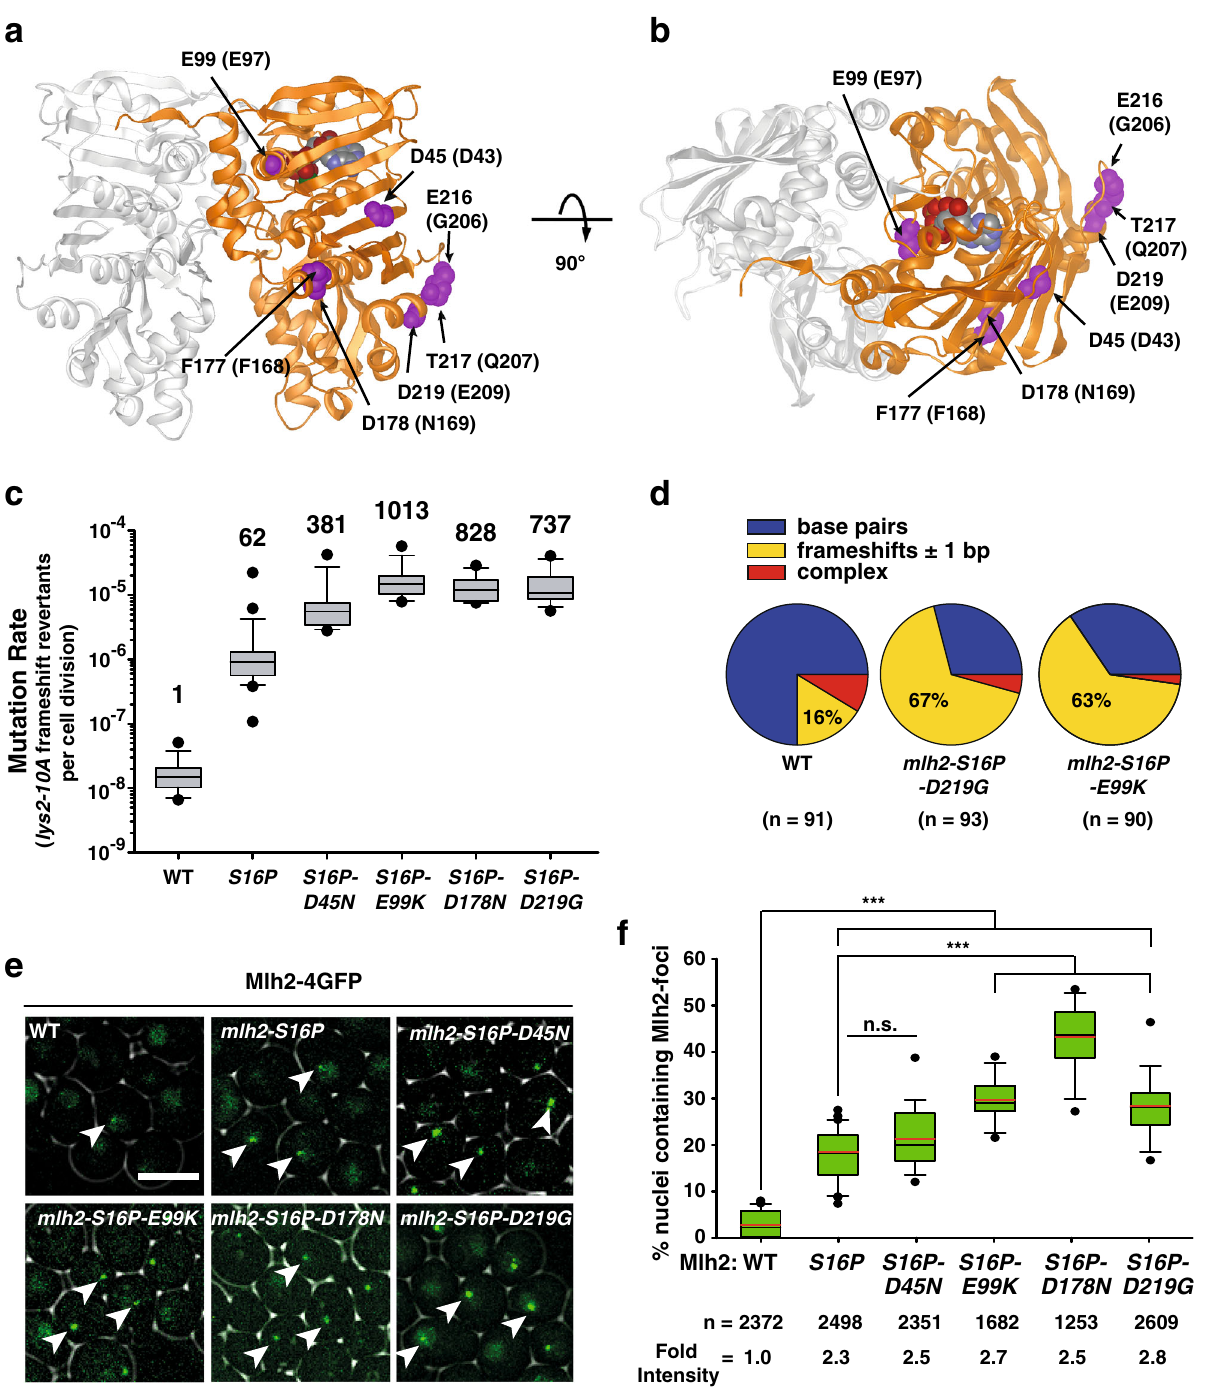
Fig. 2 Identi fi cation of mlh2-S16P mutational enhancer mutations. a Model of the Mlh1 – Mlh2 heterodimer structure (Mlh1 in gray, Mlh2 in orange) indicating residues affected by mutations with arrows (purple spheres). Mlh2 amino acid numbers are shown followed by EcMutL homolog residue numbers in parentheses. b Top view of the Mlh1 – Mlh2 heterodimer shown in a . c Frameshift mutation rates ( lys2-10A reporter) of strains carrying double mlh2 mutations integrated at the chromosomal locus shown in box plots with whiskers. Numbers on top of each box indicate the fold increase in the mutation rate over the WT and black dots represent outliers. d CAN1 mutation spectrum in the indicated strains. Independent canavanine-resistant (Can R ) colonies ( n ≥ 90 per genotype) were sequenced for CAN1 mutations. Pie graphs show the relative distribution of identi fi ed mutations. e Confocal live-cell images of Mlh2-4GFP foci (examples are shown with white arrows) in logarithmically growing cells with the indicated genotype. Bar represents 5 μ m. f Quanti fi cation of Mlh2-4GFP foci in the indicated strains, shown as box plots. The black and red lines indicate median value and average, respectively. Black dots represent outliers. n indicates the total number of cells counted per genotype. Fold intensity shows the fold increase of the foci intensity of the mlh2 mutants over the WT foci intensity. *** p <